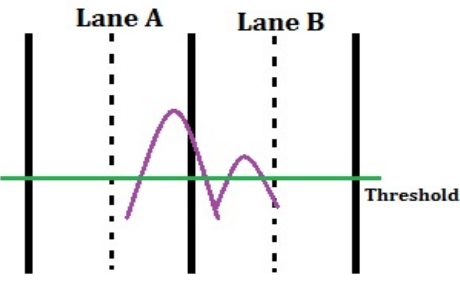
Figure 5. An example of the fast Fourier transforms (FFT) main lobe lying within the left lane and a FFT side lobe lying within the right lane.